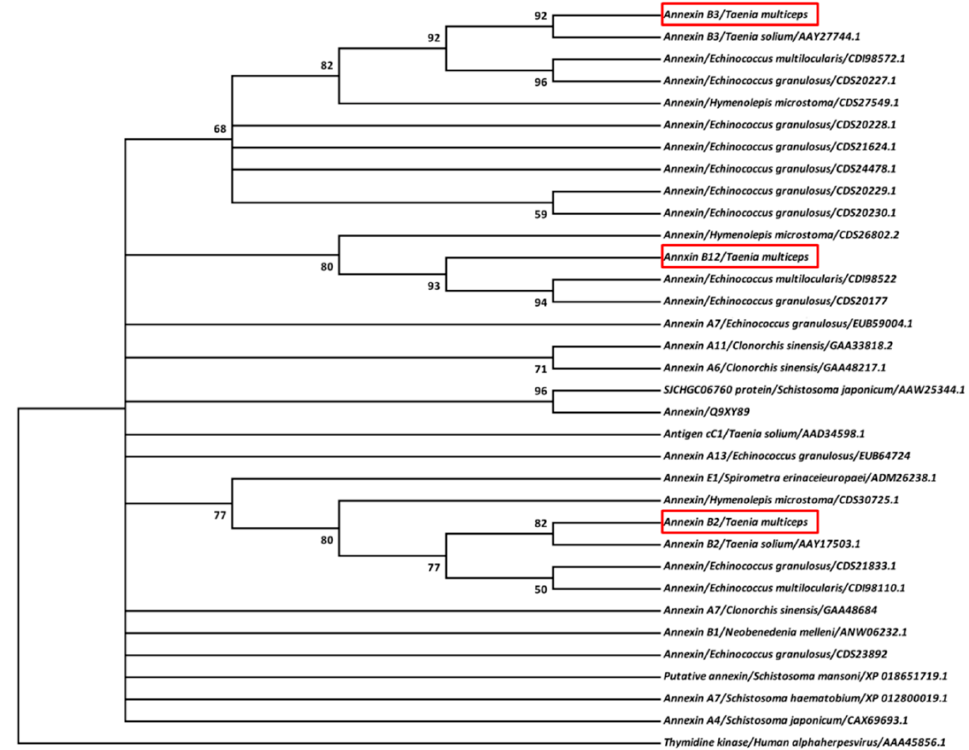
Figure 2. Phylogenetic analysis of annexin proteins. Phylogenetic analysis of the full-length amino acid sequences of T. multiceps annexins (in red boxes) and their homologs. The tree was constructed by the maximum-likelihood (ML) method and plotted with PhyML 3.1 with the Jones–Taylor–Thornton model selected by ProtTest 3 (http://darwin.uvigo.es/our-software/). Bootstrap values are indicated at the nodes (1000 replications). The scale indicates an estimate of substitutions per site, using the optimized model setting.